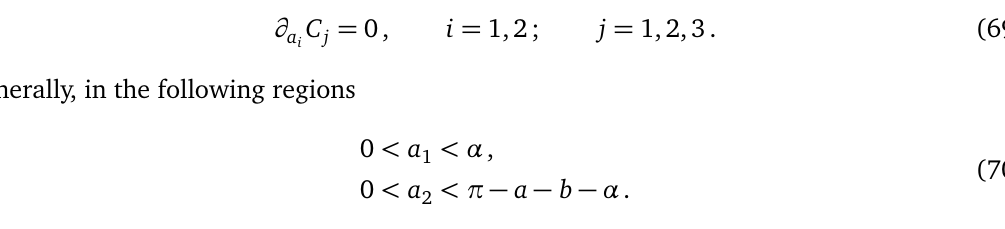
( a ) , middle: C , a 1 1 2